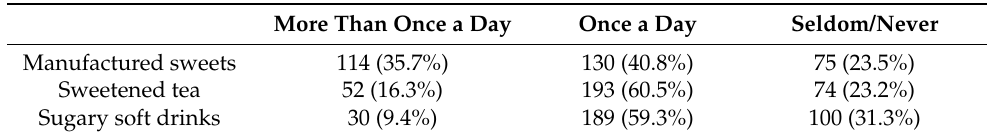
Table 4. Frequency of sugar